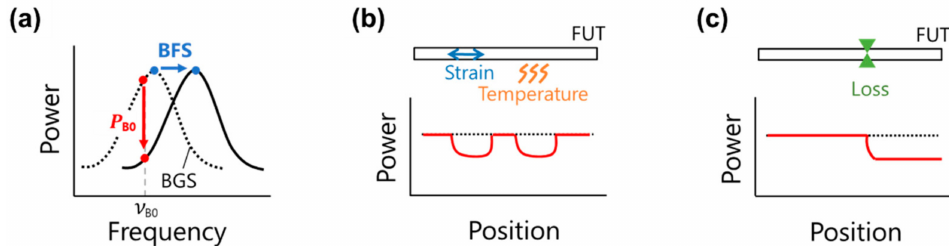
Figure 5. Schematic illustrations of the operating principle of slope-assisted BOCDR. ( a ) One-to-one correspondence between the BFS and the spectral power P B0 at frequency ν B0 . The dotted curve is the initial BGS, and the solid curve is the BGS shifted to higher frequency because of strain and/or heat. ( b ) P B0 distributions along the FUT with (solid curve) and without (dotted line) partial strain and heat. ( c ) P B0 distributions along the FUT with (solid curve) and without (dotted line) a point loss. Reproduced with permission from [59]. Copyright (2016)